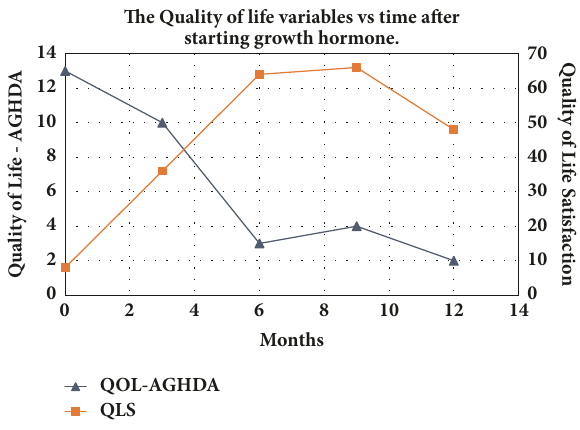
Figure 3: The patient’s Quality of Life (QoL) scores with time. QoL-AGHDA: Quality of Life-Assessment of Growth Hormone Deficiency in Adults. QLS: Quality of Life Satisfaction. 1 A decrease in score for QoL-AGHDA indicates an improvement in QoL- AGHDA, whereas an increase in QLS indicates an improvement while taking GH